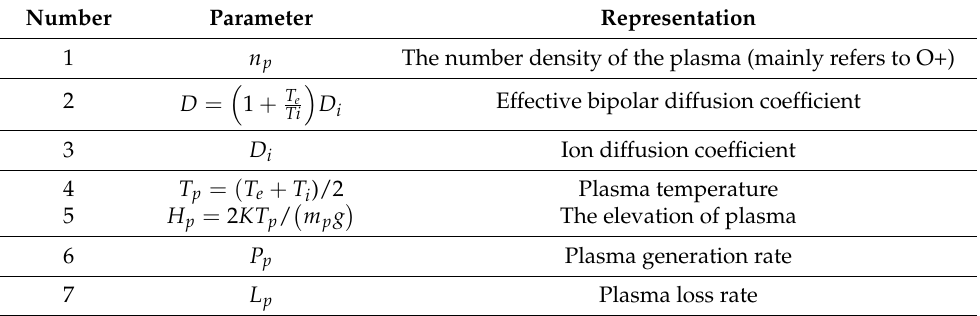
Table 4. The meaning of related parameters in the above Formula